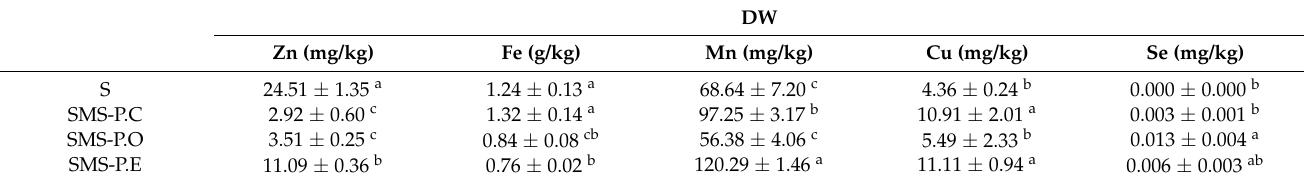
Table 2. Effect of cultivated different variety of mushroom on microelements of SMS.